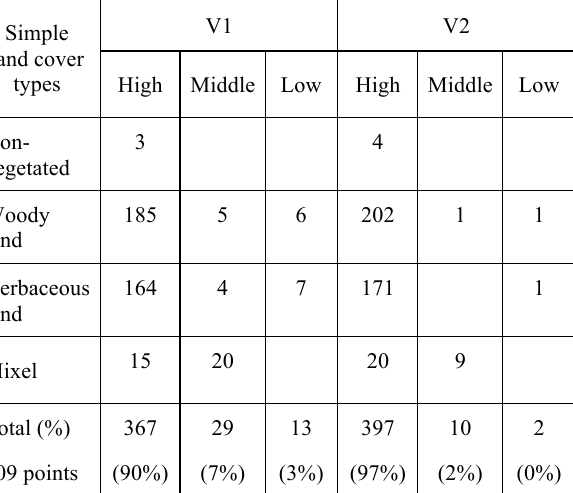
Table 2. The reliability of the two interpreters’ labels based on simple land cover types.